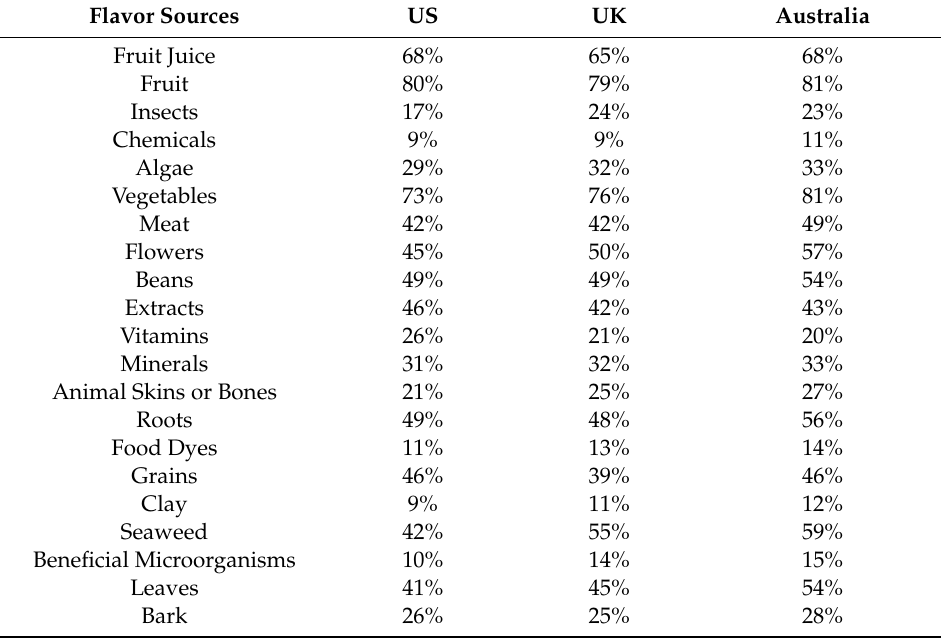
Table 5. Percentages of US, UK, and AUS respondents rating various flavor sources as acceptable for natural foods and